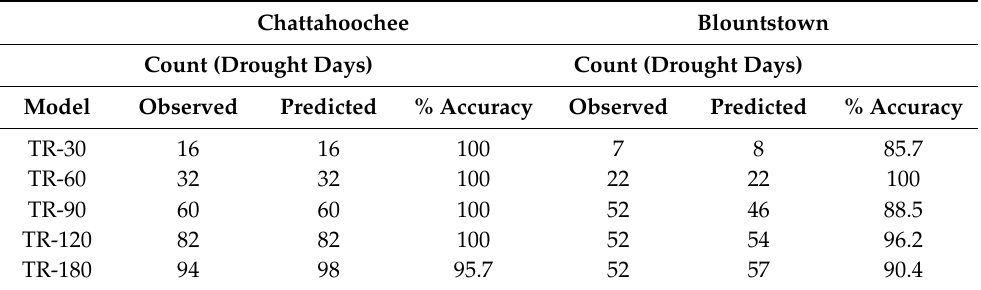
Table 3. Percentage accuracy of hydrological drought detected by the transformer models.